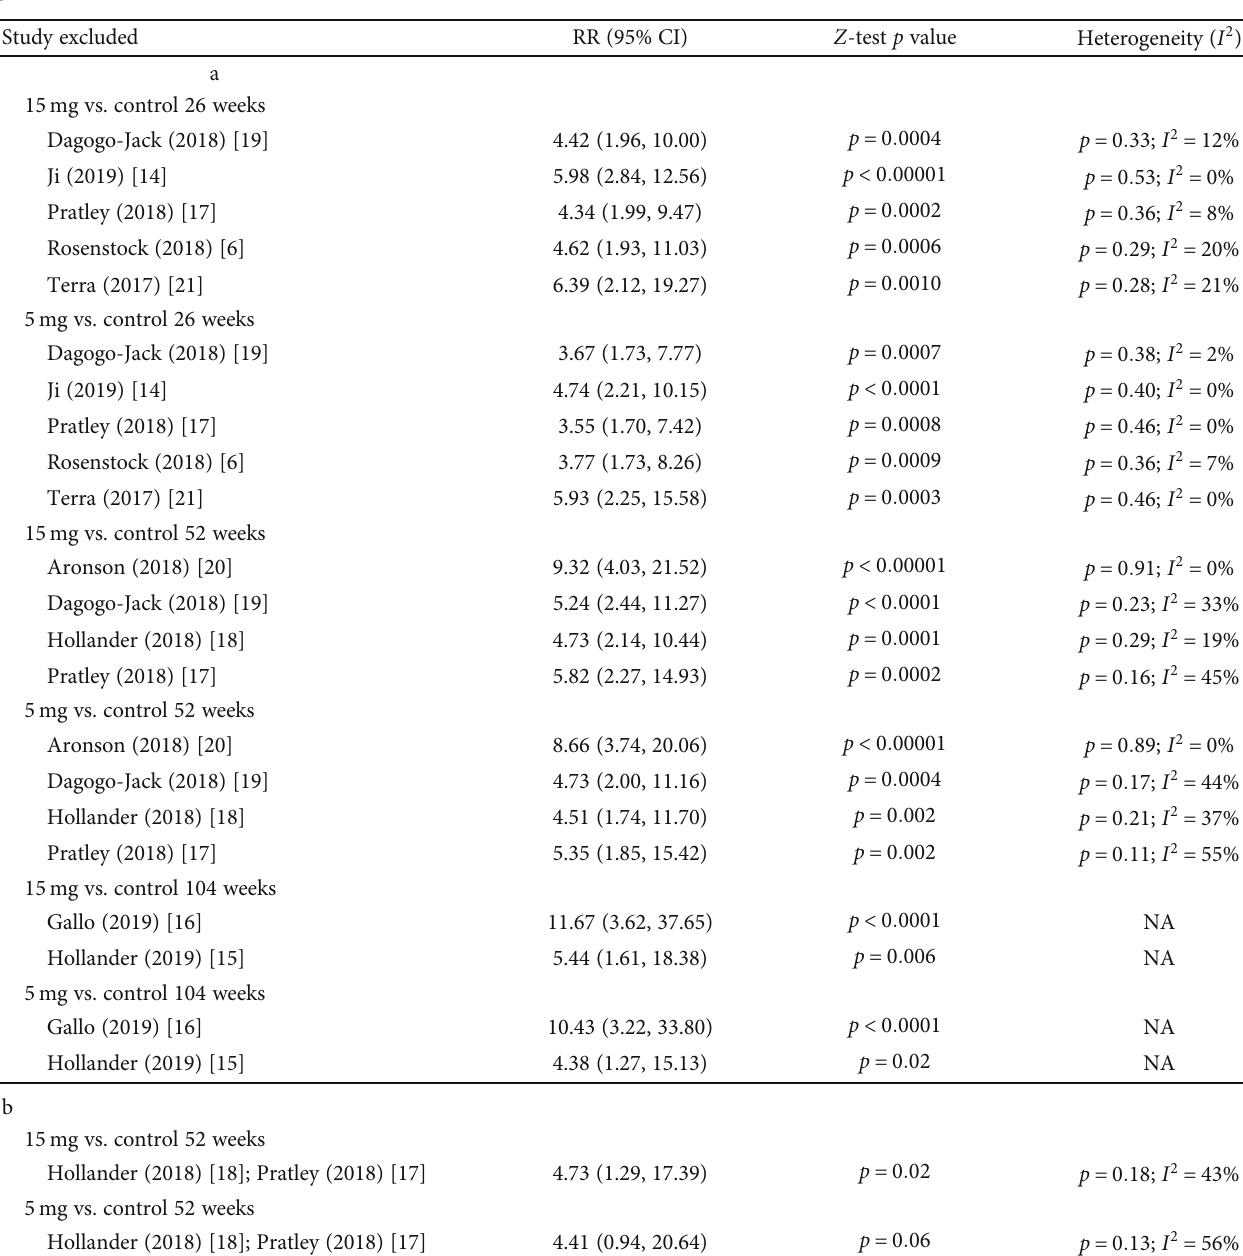
Table 2: a: Leave-one-out sensitivity analysis for GMIs (ertugli fl ozin vs. control). b: Sensitivity analysis by excluding two studies that were not